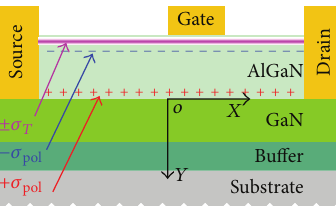
Figure 1: Cross-sectional structure of AlGaN/GaN HEMT. Positive is caused by spontaneous polarization and sheet charge +𝜎 pol piezoelectric effect. Equivalent negative sheet charge −𝜎 on the AlGaN surface. Surface trap states are represented with ±𝜎 𝑇 .